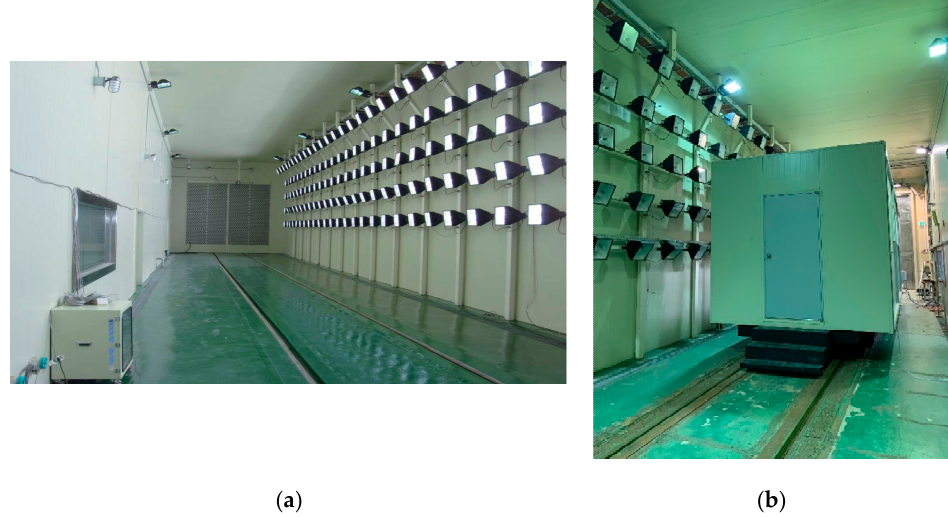
Figure 2. Real-scale environmental chamber: ( a ) inside the environmental chamber, ( b ) classroom chamber inside the en- vironmental chamber. chamber inside the environmental